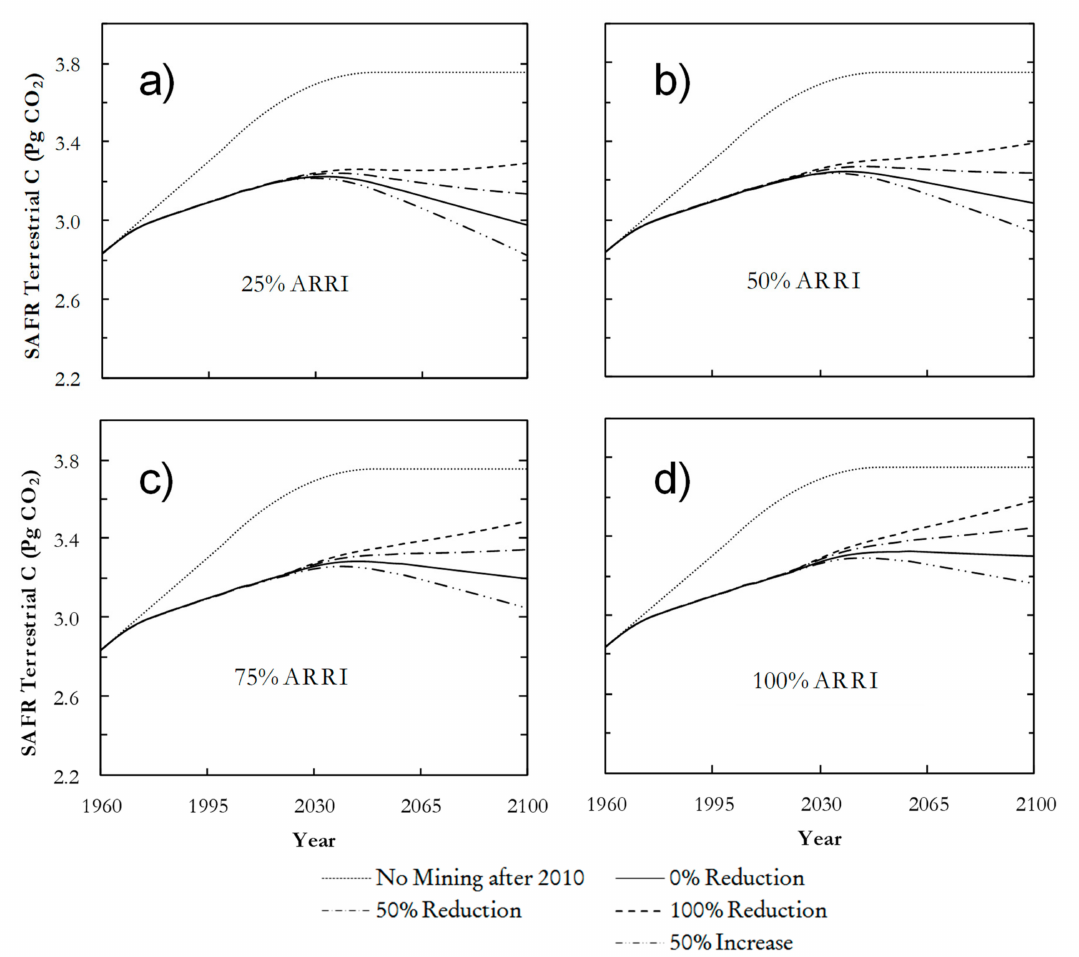
Figure 11. Terrestrial carbon disturbance under a range of reclamation practices and mining rates. The 0% reduction in the plots reflects a business-as-usual mining disturbance equal to 12,153 ha y − 1 . Mining disturbance rates are reduced (50% and 100%) or increased (50%) relative to the business-as-usual rate, considering the potential for reduced mining from decreased demand, but also the potential for increased land disturbance as seams are thinner and harder to reach (e.g., data results show potential for both trends in Pericak et al. [9]). Projection is carried to 2100 because there is ample coal supply in the region to mine at the current rate throughout the 21st century ([20], and data from references therein). The di ff erent plots represent di ff erent mixtures of reforestation and grassland reclamation on future sites, assuming that either method could be chosen. Currently, grassland reclamation is the de facto approach. Plots show reclamation mixtures including ( a ) 75% grassland and 25% reforestation (ARRI) reclamation, ( b ) 50% grassland and 50% reforestation reclamation, ( c ) 25% grassland and 75% reforestation reclamation, and ( d ) 100% reforestation